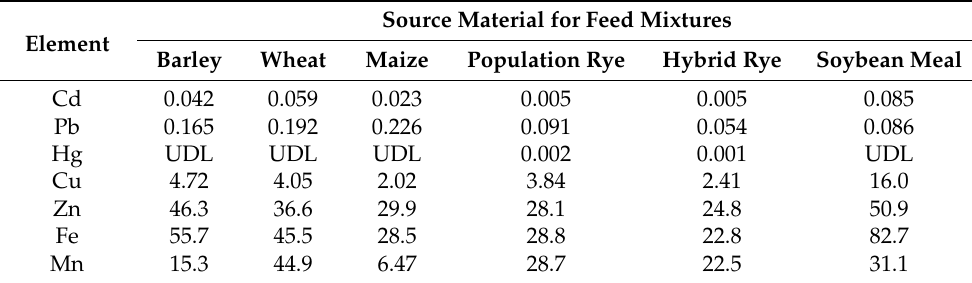
Table 3. The mean content of heavy metals (mg/kg) in grains, on a dry matter basis, used for preparing control and experimental feed